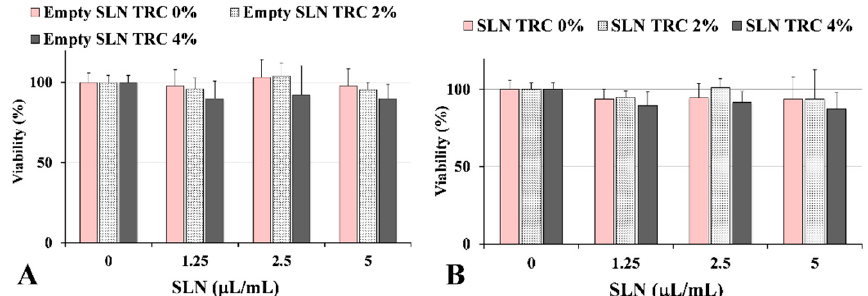
Figure 5. Viability (expressed as % of the control) (MTT assay) measured in control 3T3 fibroblasts (0) and cells treated for 24 h with three aliquots (1.25, 2.5, 5 µL/mL) of unloaded SLNs (empty SLN) ( A ) and 8-MOP-loaded SLNs (SLN) ( B ) with different % of TRC (0%, 2%, 4%). Data are expressed as a mean ± standard deviation (SD) of three independent experiments involving triplicate analyses for each sample ( n = 9).